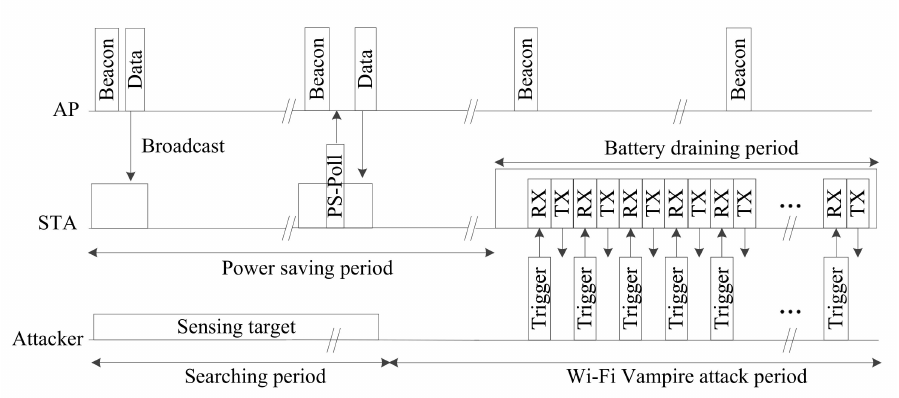
Figure 3. Timing diagram for the battery draining